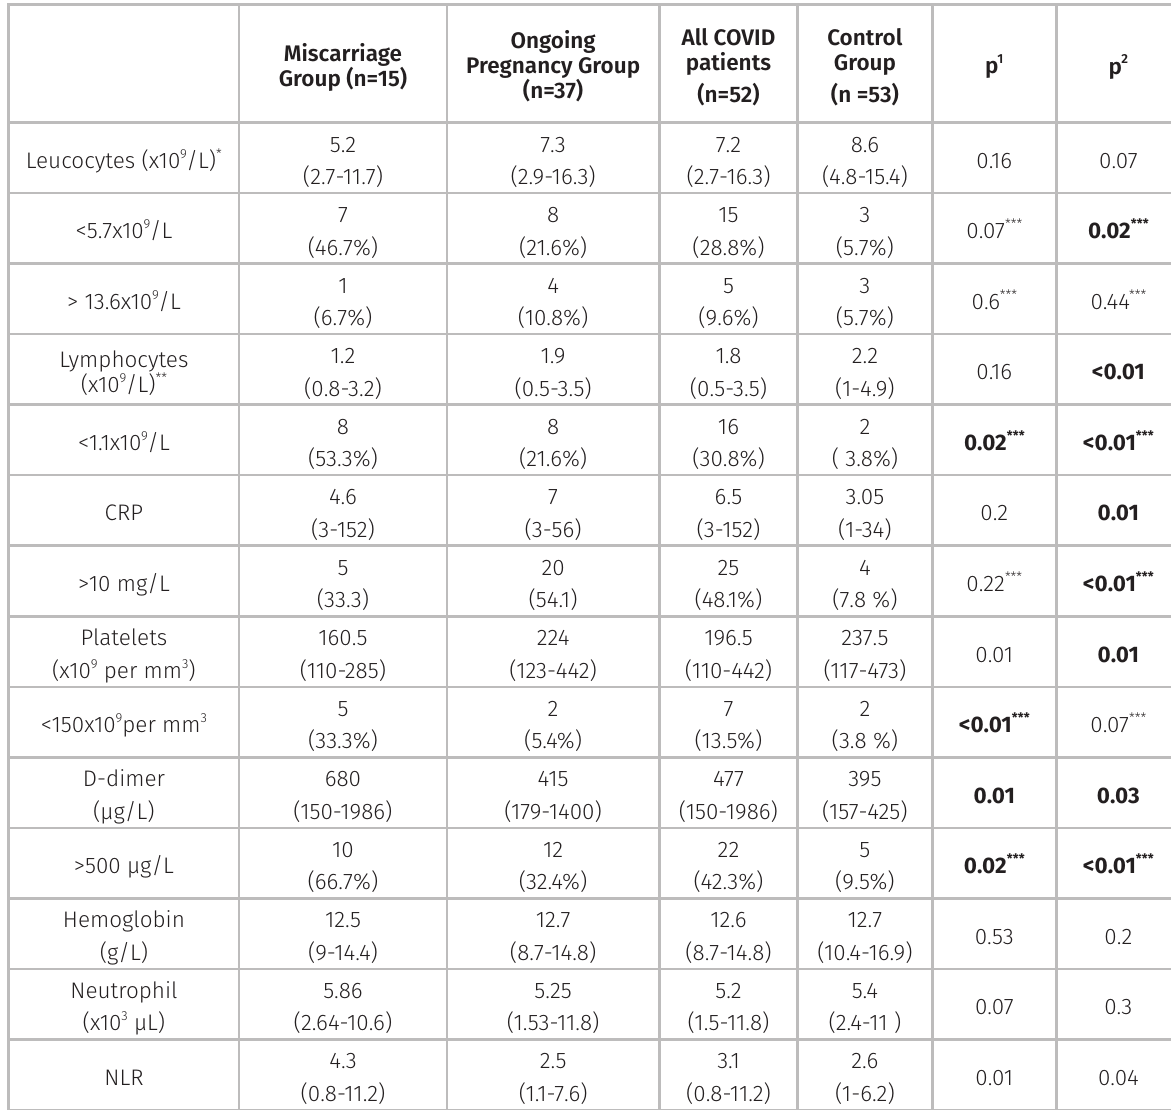
Table III. Laboratory Findings.